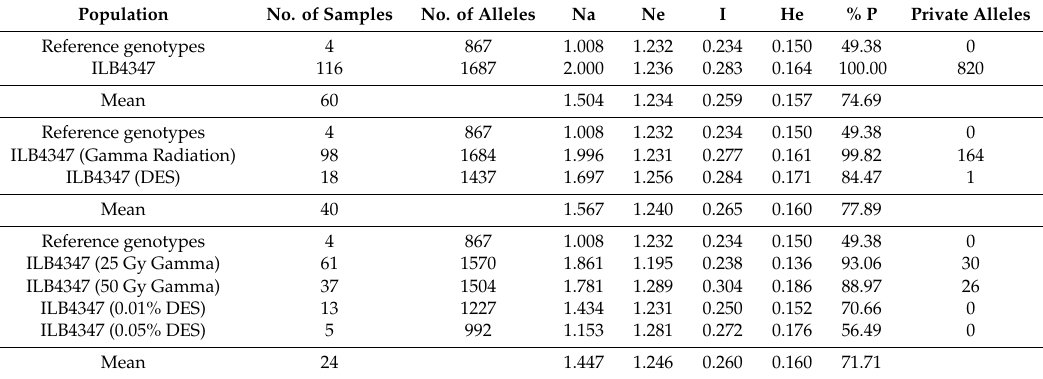
Table 3. Diversity parameters of mutant populations obtained from the analysis of 1687 AFLP alleles. Population No. of Samples No. of Alleles Na Ne I He % P Private Alleles Reference genotypes 4 116